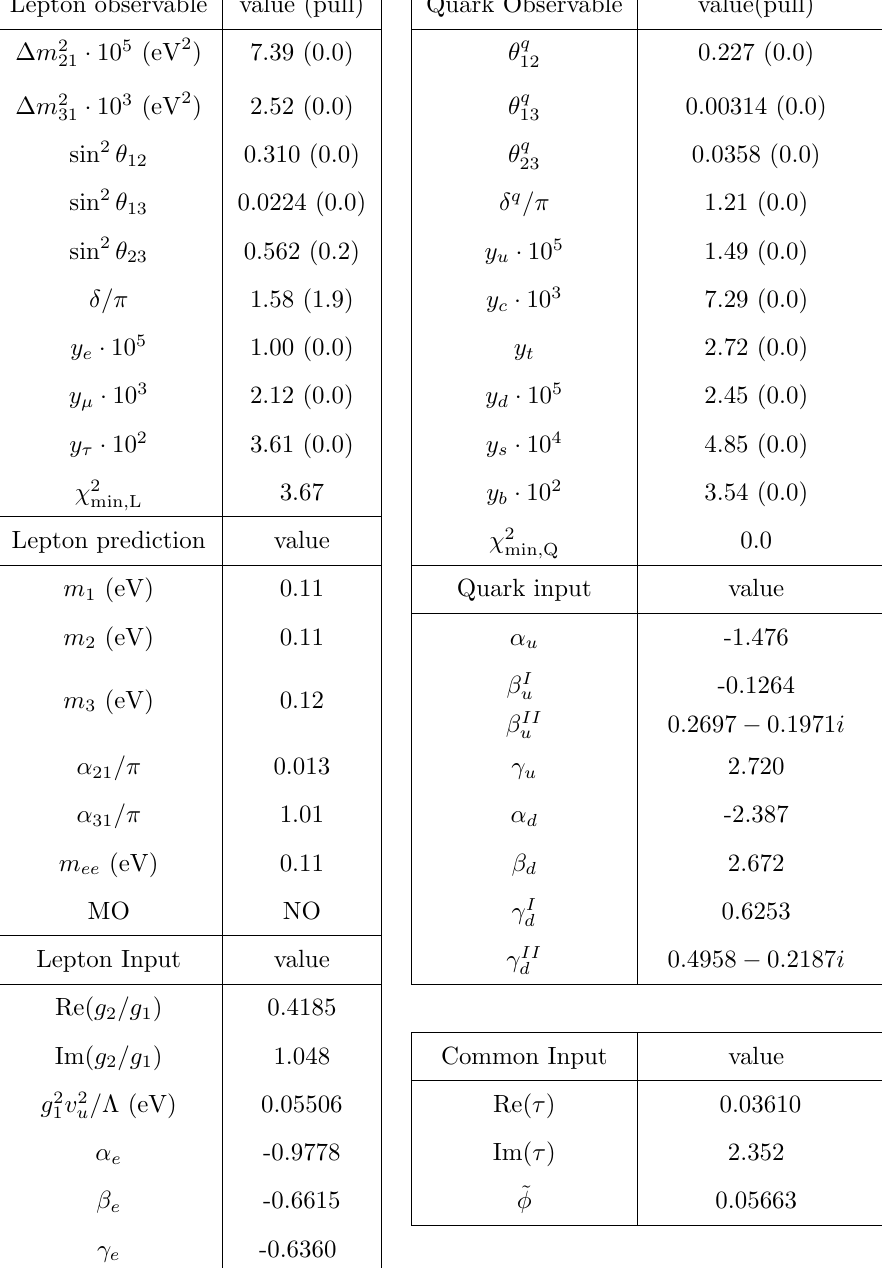
; Y III . u d contribution min,L quark contribution, and quark inputs. min,Q